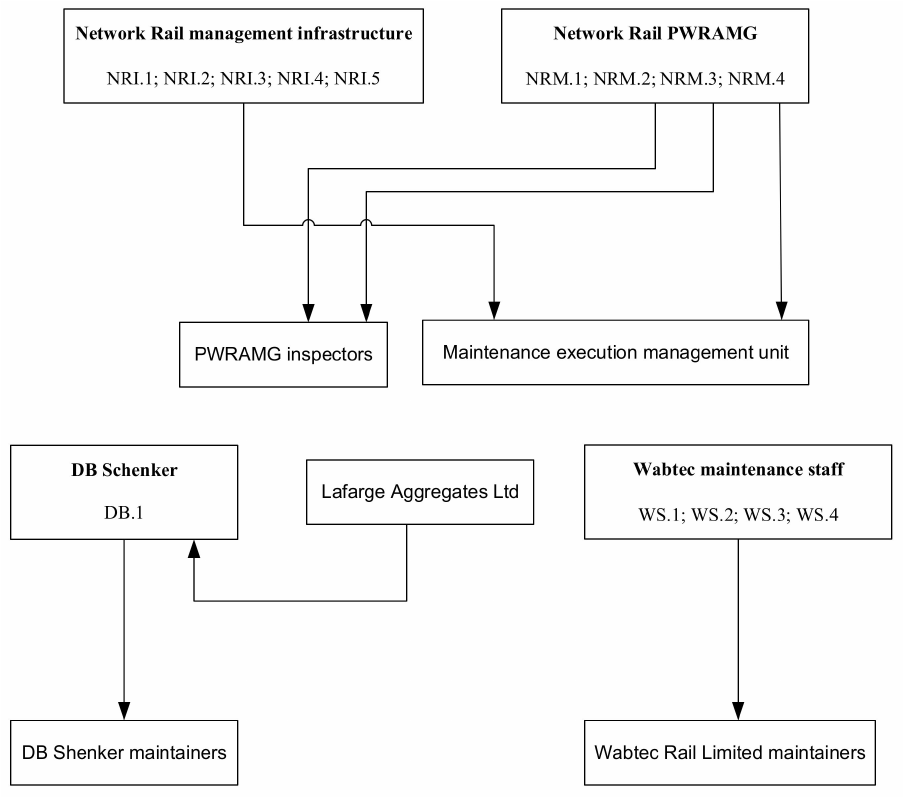
Figure 6. Focus on main unsafe constraints and system components